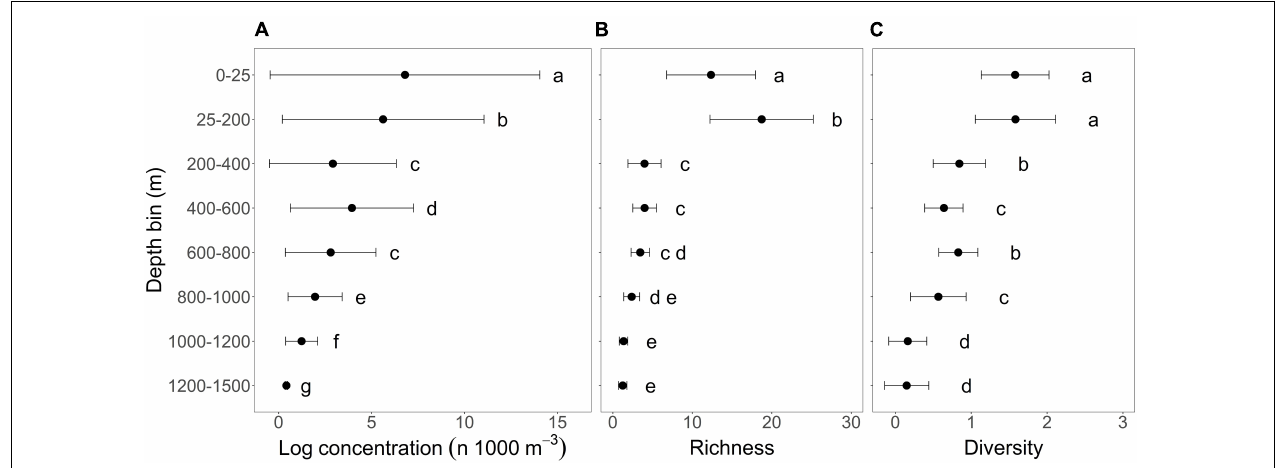
FIGURE 2 | Variation in (A) total ichthyoplankton abundance (log number of larvae 1,000 m − 3 ), (B) family-level richness (number of families), and (C) family-level Shannon diversity index among depth bins sampled in the northern Gulf of Mexico. Points represent mean values and horizontal bars indicate standard deviations. Within each larval measure, lower case letters indicate significant differences among depth bins resulting from post-hoc Tukey’s HSD tests.